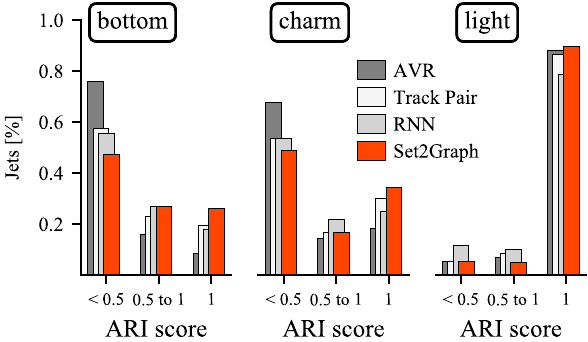
Fig. 8 ARI scores for the different flavors of jets. We consider 3 cate- gories: Perfect – jets with an ARI score of exactly 1, Intermediate – a score between 0.5 and 1 and Poor – scores below 0.5